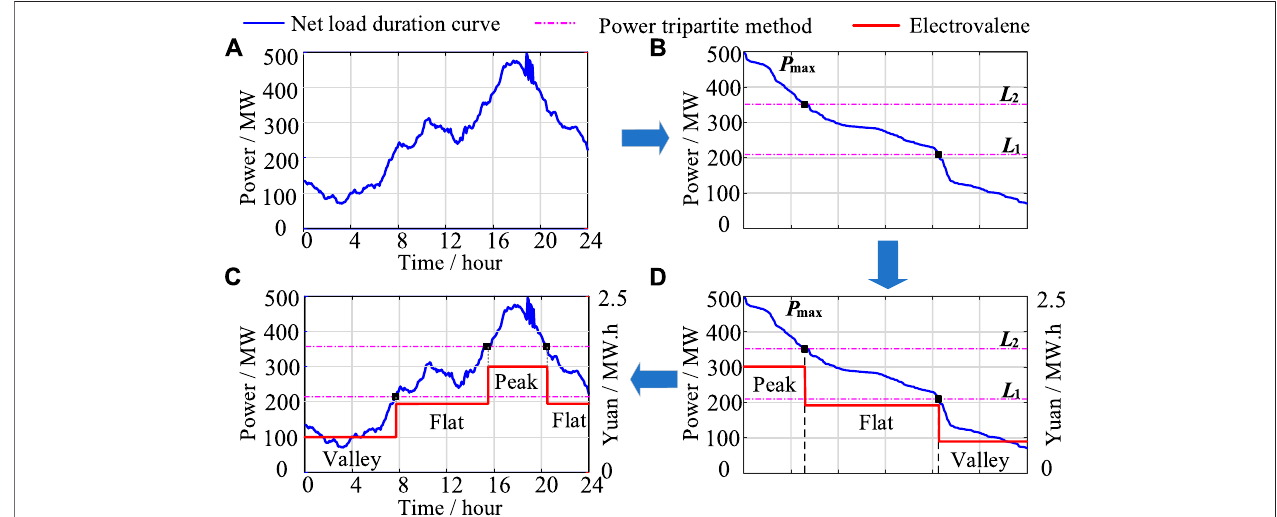
FIGURE 3 | Dynamic electricity price-setting method of power trisection.